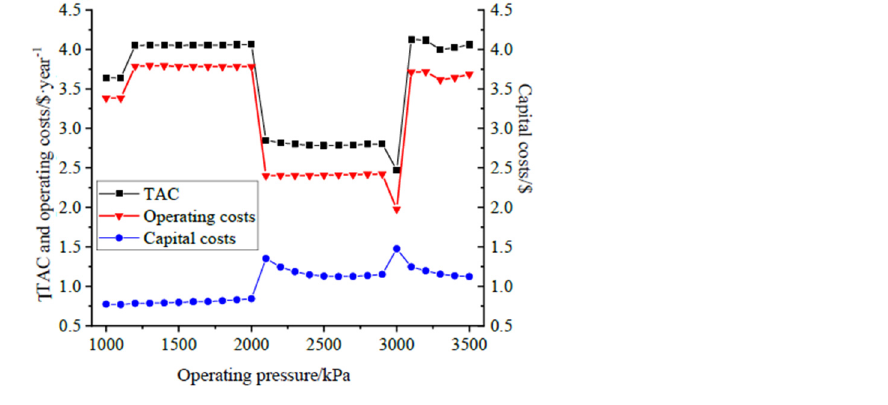
Figure 4. The costs of the dethanizer at different pressures.